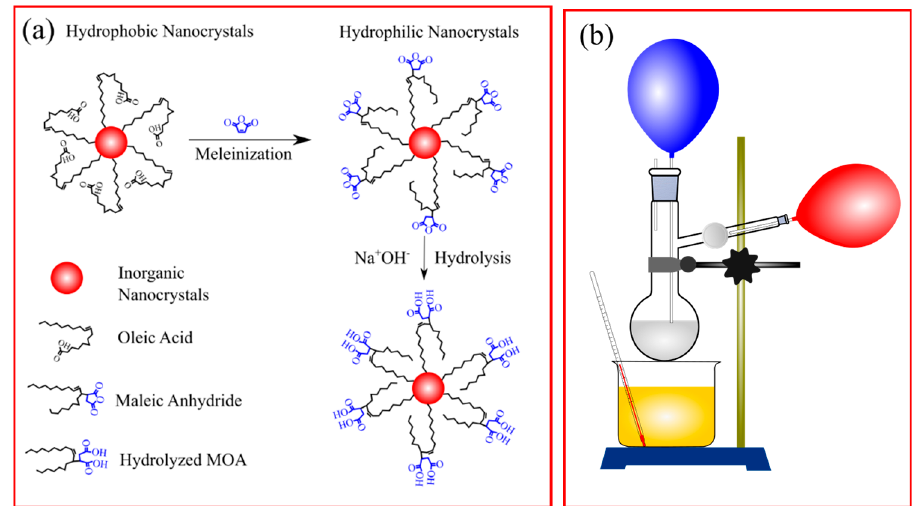
Figure 7. ( a ) Scheme of surface modification of UCNPs by maleic anhydride (MA); ( b ) the experimental apparatus is also sketched.